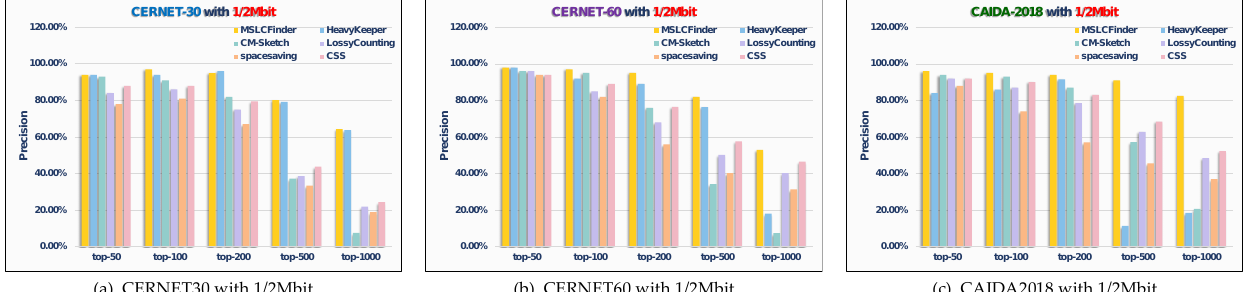
Figure 13. Experiments on precision vs. six methods of three datasets with 1/2Mbit. ( a ) CERNET-30 with 1/2 Mbit. ( b ) CERNET-60 with 1/2 Mbit. ( c ) CAIDA-2018 with 1/2 Mbit.